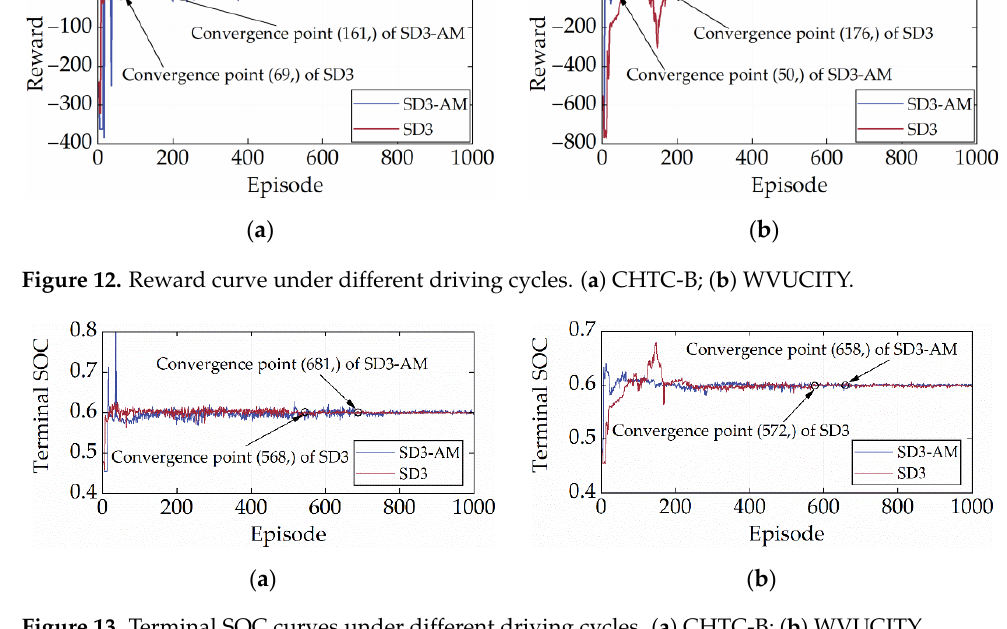
Figure 13. Terminal SOC curves under different driving cycles. ( a ) CHTC-B; ( b ) WVUCITY.